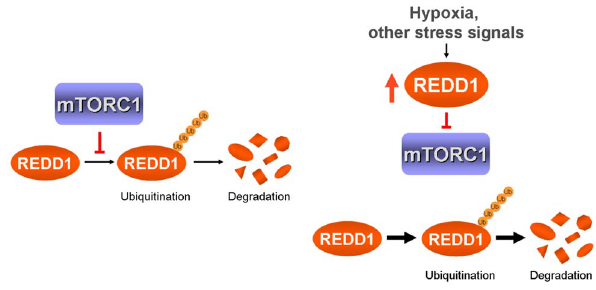
Figure 6. The mTORC1-REDD1 limits the inhibitory action of REDD1 on mTORC1. When mTORC1 is active, ubiquitination and proteasome dependent degradation of REDD1 is inhibited (left panel). Under conditions of hypoxia and other stress stimuli, REDD1 is transcriptionally induced, leading to mTORC1 inhibition. As a conse- quence, REDD1 ubiquitination and degradation is no longer restricted by mTORC1 (right panel). This mTORC1-REDD1 feedback mechanism limits the inhibitory action of